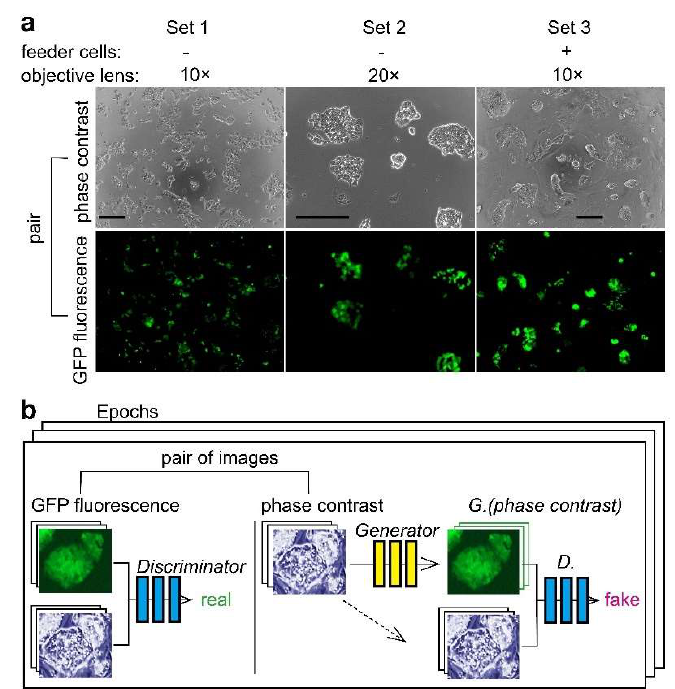
Figure 1. Experimental design of deep learning of miPS-LLC cm cell morphology. ( a ) Cells image sets for deep learning. For Sets 1 and 2, miPS-LLC cm cells were cultured in 96-well plates for 1–2 days. Cell images were taken using a 10 × or 20 × objection lens for each set. For Set 3, miPS-LLC cm cells were cultured for one day on MEF cells previously immobilized in 24-well plates. Bars = 200 µ m. ( b ) Training a conditional generative adversarial network (CGAN) to map grayscale bright-field cell images into color dark-field fluorescence images. Learning was performed with several hundreds to thousands of images per epoch; the final epoch number was set to 200.